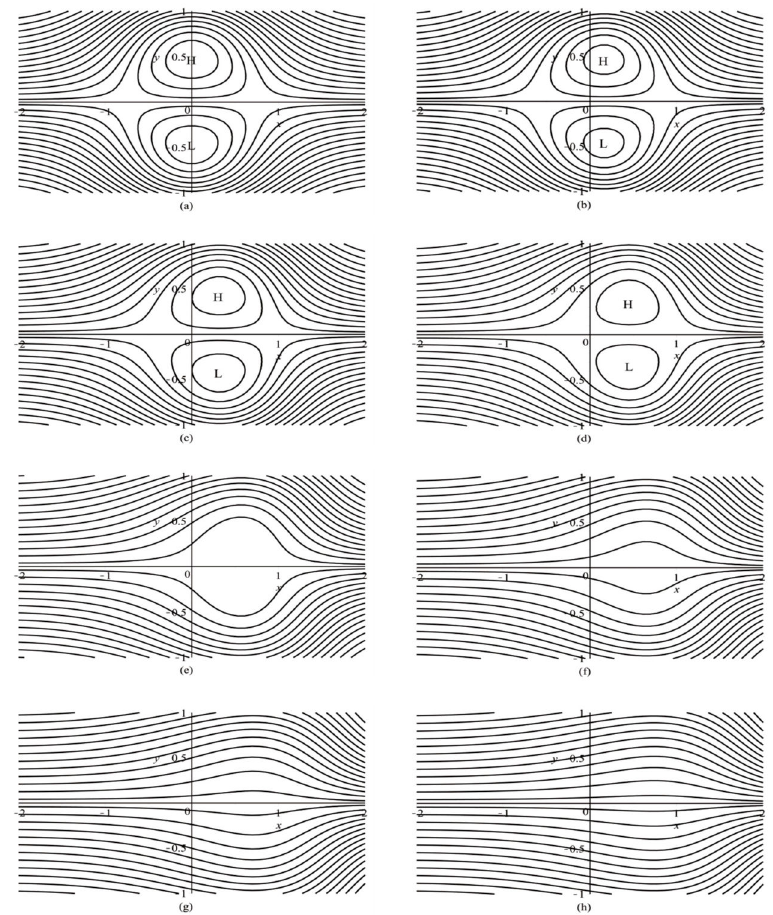
Figure 2. Blocked flow field of an unheated soliton solution on the ( a ) 1st, ( b ) 5th, ( c ) 9th, ( d ) 13th, ( e ) 17th, ( f ) 21st, ( g ) 25th, and ( h ) 29th day (unit: 1500 km). Because the wave amplitude of the dipole blocking flow increases monotonically with α 0 √ (cid:16) (cid:17) α δ c δ /2 λ /2 > 2 χ 0 , the dipole blocking flow is dispersive. From this analysis, the e ff ect of the g 0